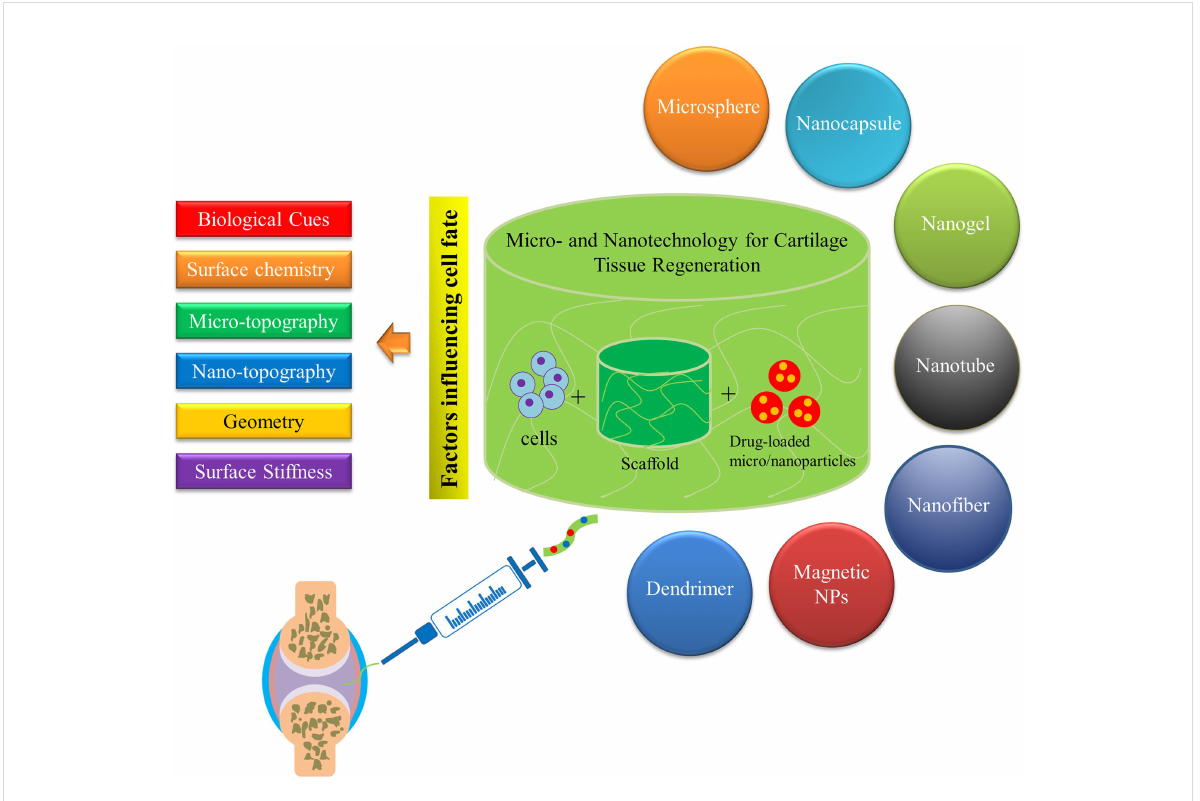
Figure 1: A schematic representation of the issues covered in this